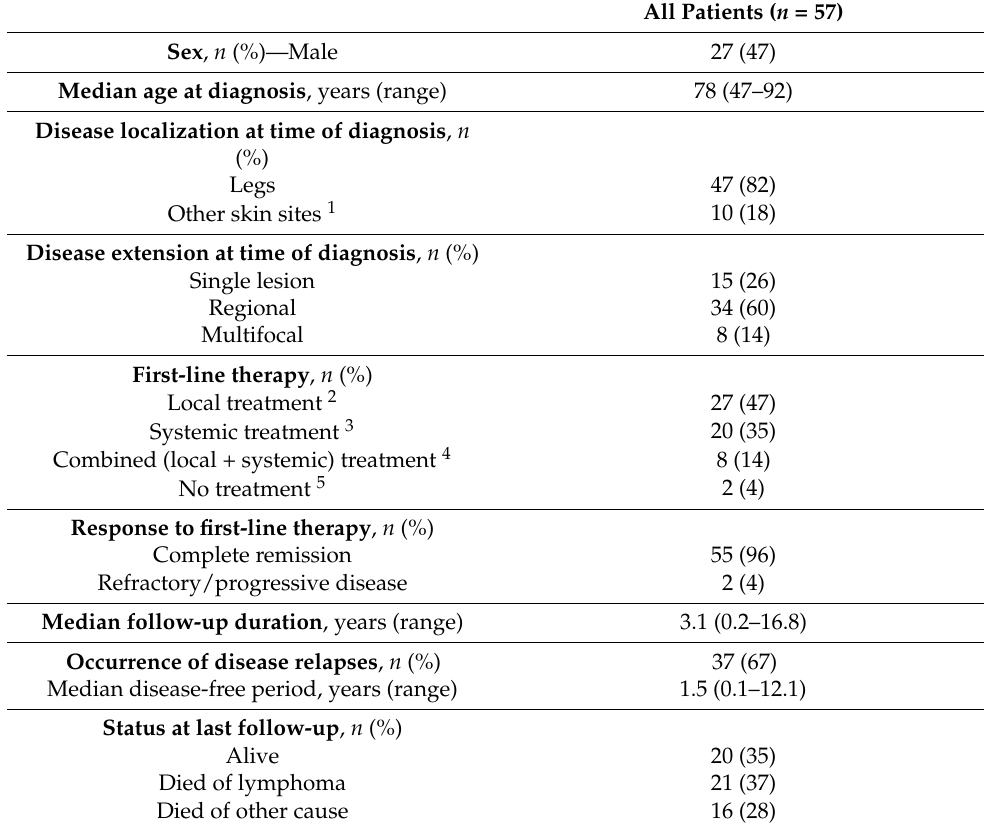
Figure 1. Overview of 73 included biopsy samples from pre-treatment and relapse/refractory disease of 57 patients with primary cutaneous diffuse large B-cell lymphoma, leg type, including paired analysis of both time points in 16 patients. Table 1. Clinical and immunophenotypic characteristics of 57 patients with primary cutaneous diffuse large B-cell lymphoma, leg type.